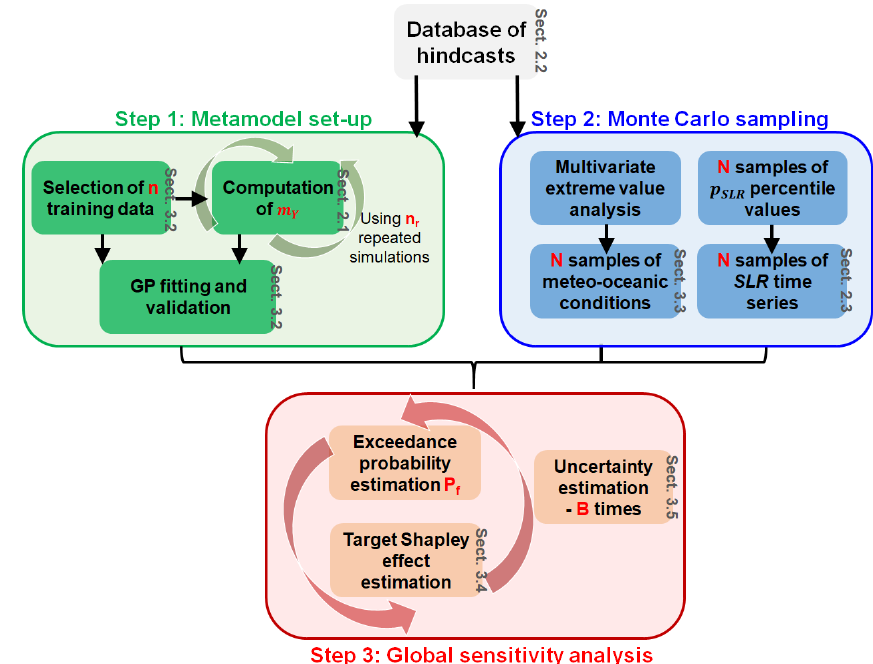
Figure 5. Flowchart of the procedure. The sections describing the methods/data are indicated in grey next to the